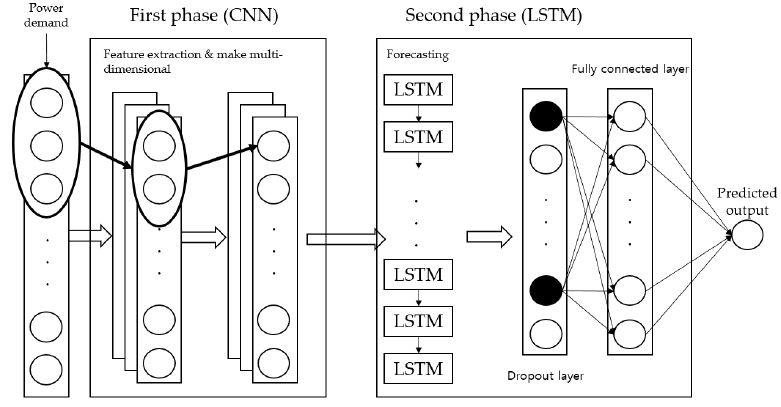
Figure 3. CNN-LSTM hybrid model.